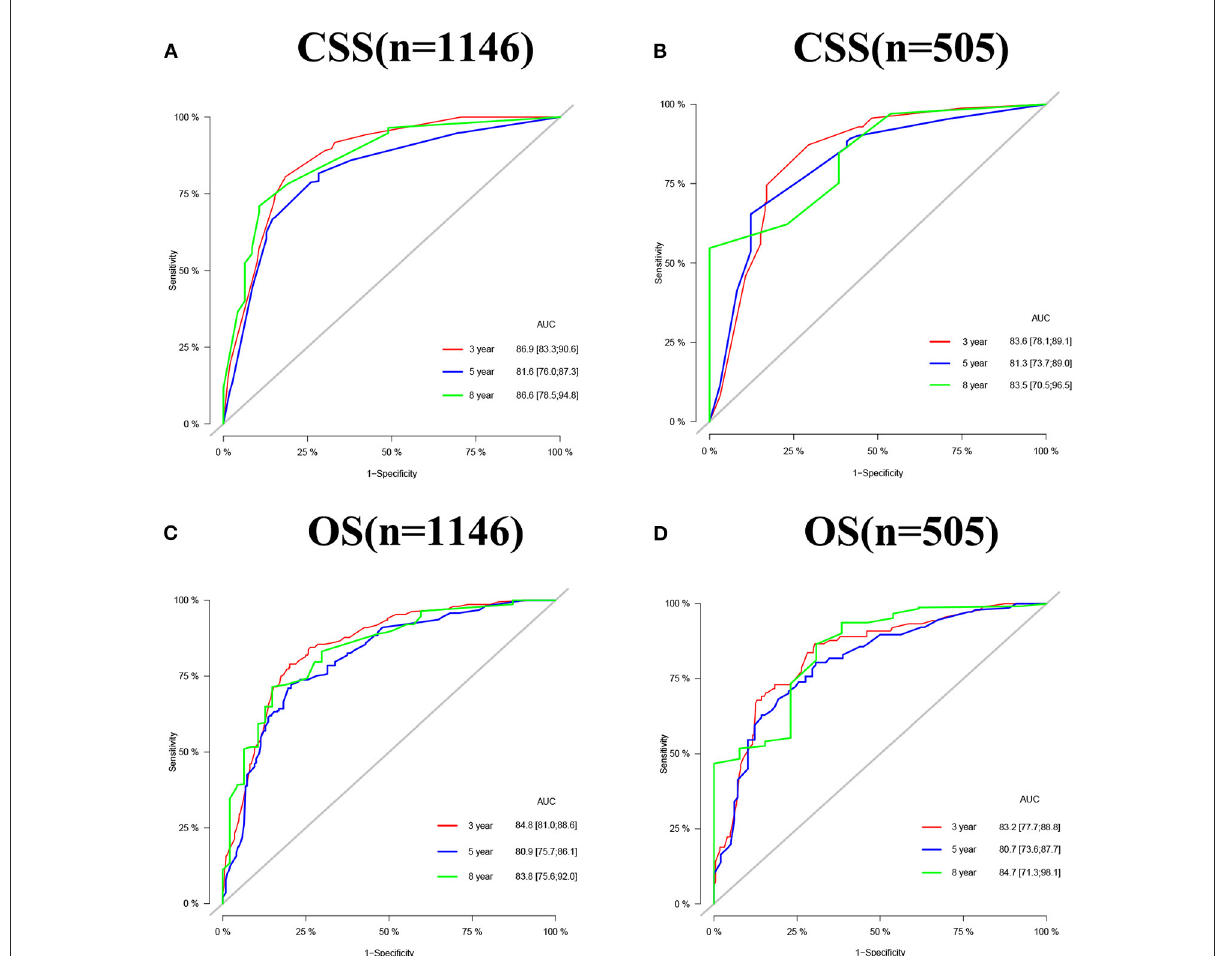
FIGURE4 AUC for predicting 3-, 5-, and 8-year CSS (A,B) and OS (C,D) in middle aged high-risk prostate